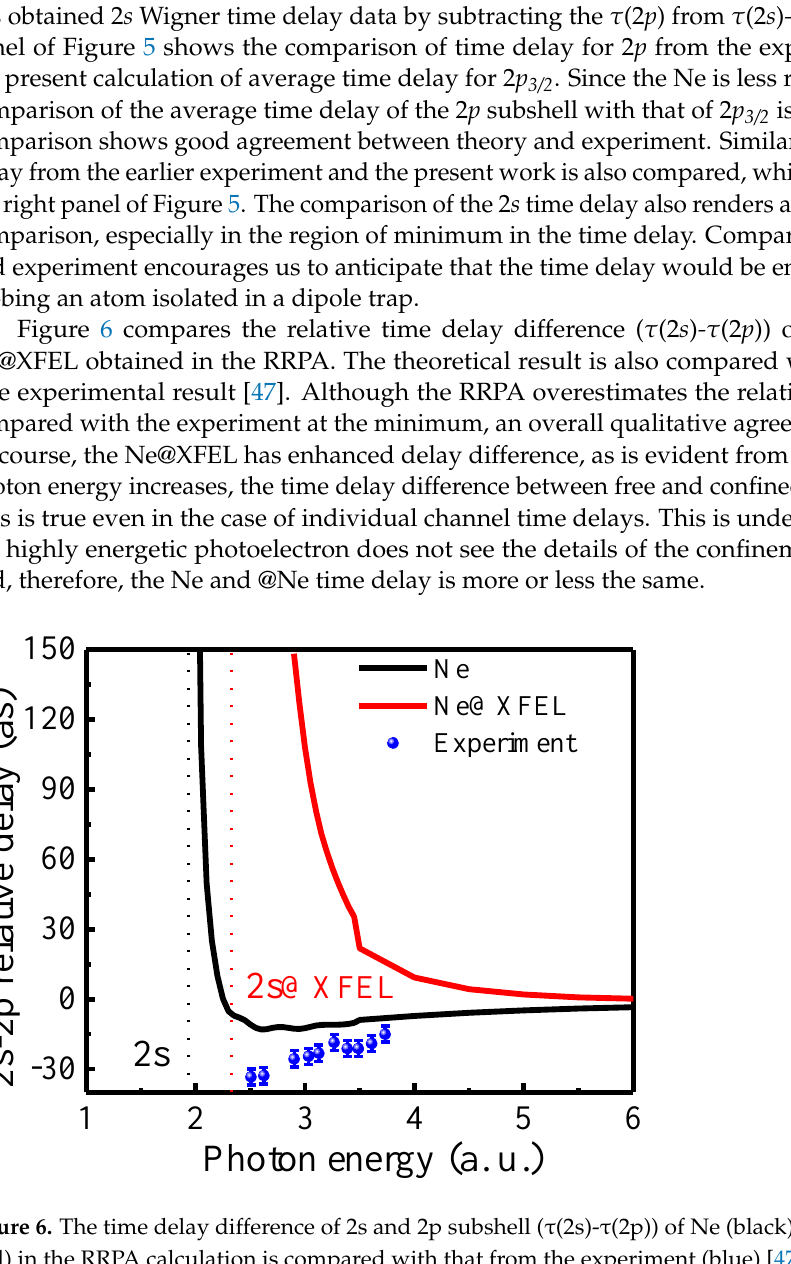
Figure 7. Photoionization cross section (σ) of 3p 3/2 (Left), 3p 1/2 (Middle), and 3s (Right) subshells of Ar (black) and Ar@XFEL (red). Solid, dashed, and dotted vertical lines represent the threshold for 3p 3/2 , 3p 1/2 , and 3s thresholds of free (black) and confined atom (red), respectively.